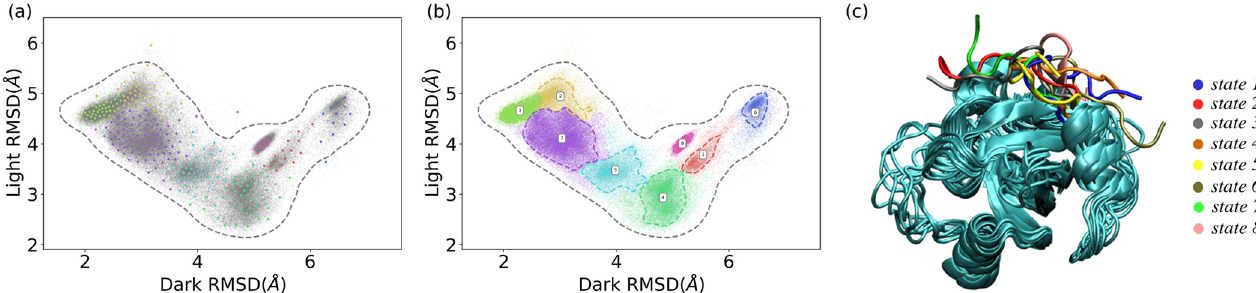
Fig 3. Markov state model (MSM) construction of eight macrostates based on the 300 microstates generated using k -means clustering analysis of VVD MD simulations. (a) Plot of 300 microstates on 2D RMSD surface belonging to eight macrostates with different colors representing different macrostates; (b) Distribution of each macrostate on the 2D RMSD surface; (c) Representative structures of eight macrostates.